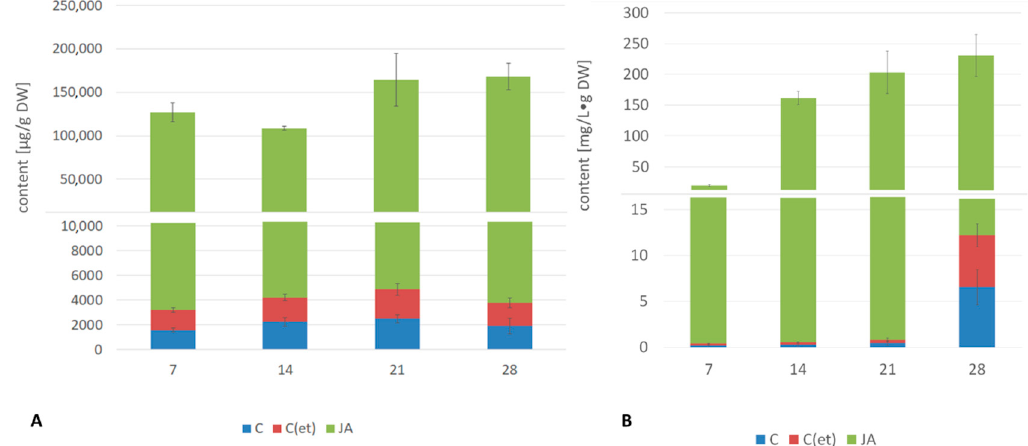
Figure 7. The effect of jasmonic acid on the content of saponins in the root tissue ( A ) and saponins released to the culture medium ( B ). C—control, C(et)—control samples supplemented with 70% ethanol, JA—jasmonic acid-elicited samples. See detailed data and statistical significance in Tables S11 and S13.